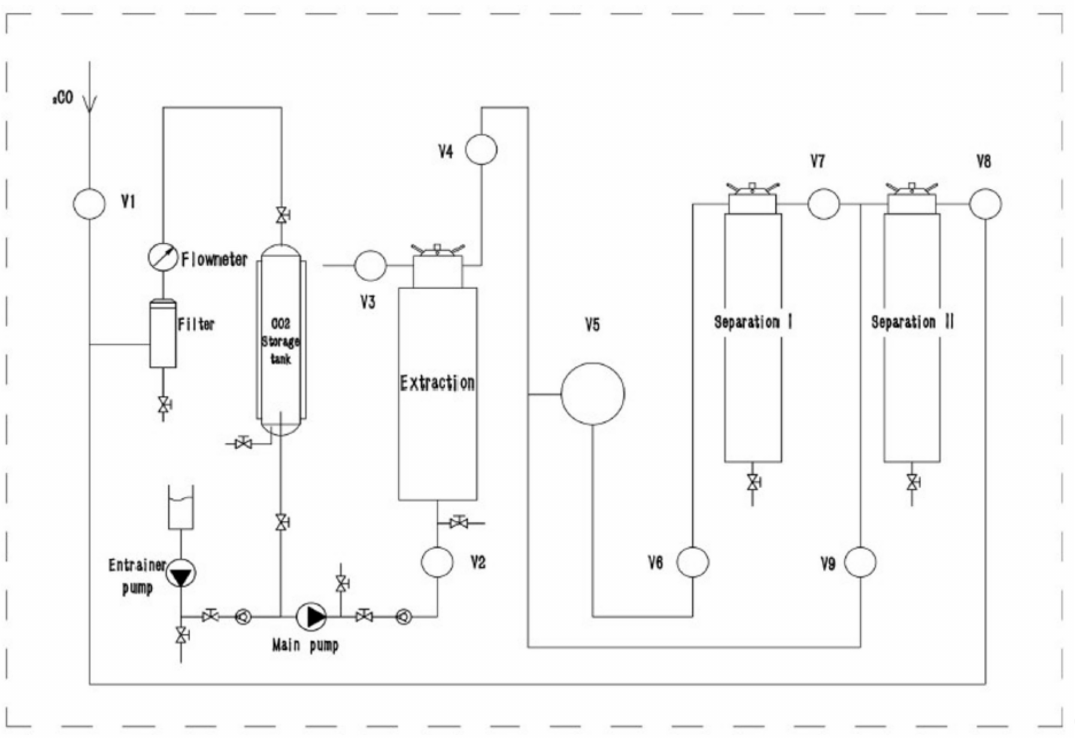
Figure 9. Process diagram of pilot-scale supercritical fluid extractor CAREDDI SCFE-5L. Flow rates and temperatures were automatically controlled. Manual back pressures were used to control the pressure in the extraction tank and both separation tanks. The maximum extraction pressure was 48 MPa, and the maximum separation pressure was 25 MPa. Dynamic extraction was used, with a CO 2 flow rate of 100 L h − 1 and an